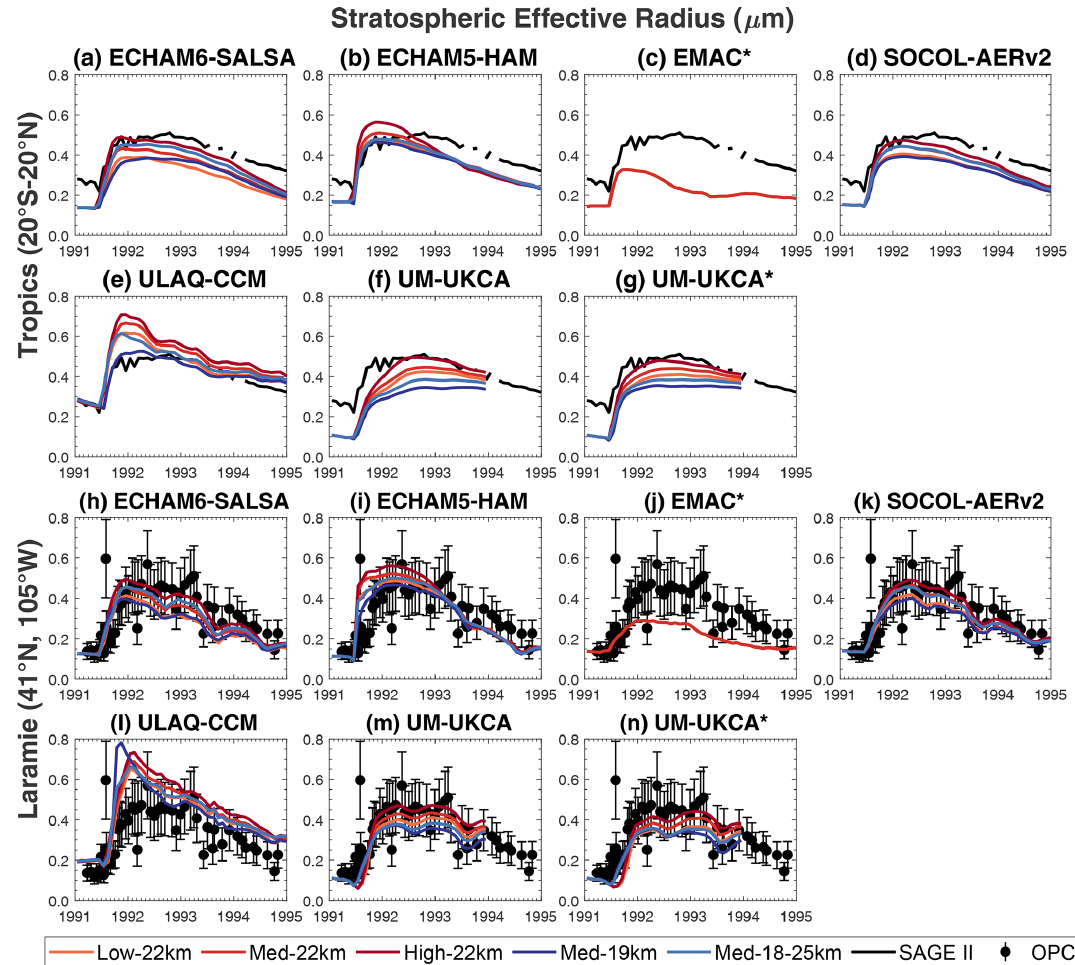
Figure 8. Time evolution of stratospheric effective radius (µm) in the tropics (a–g) and over Laramie (41 ◦ N, 105 ◦ W) (h–n) . In the panels of the first row, the stratospheric effective radius of the models is calculated between 21–27km (50–20hPa) to be compared with the available SAGE II observations. In the panels of the second row, it is calculated between 14–30km (130–10hPa) to be compared with the OPC observations. ∗ Models with spatially spread SO 2